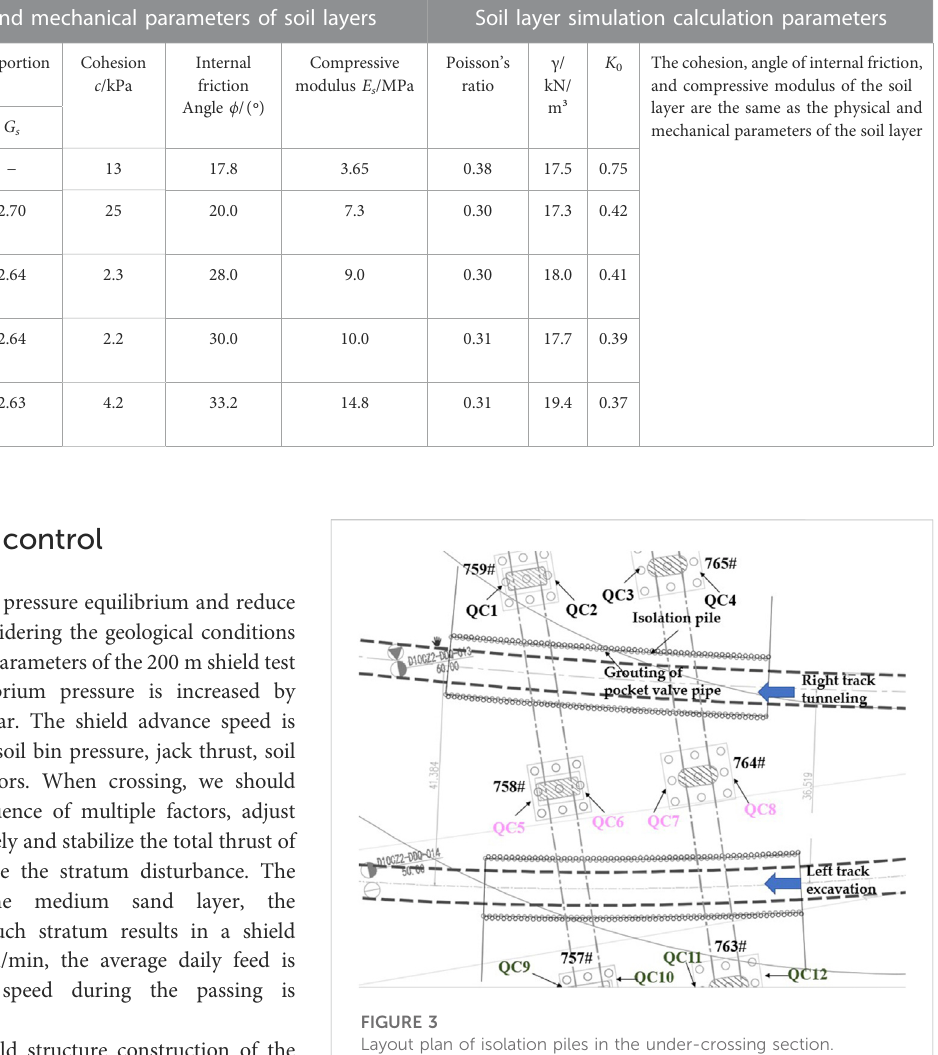
TABLE 1 Site soil layer information.